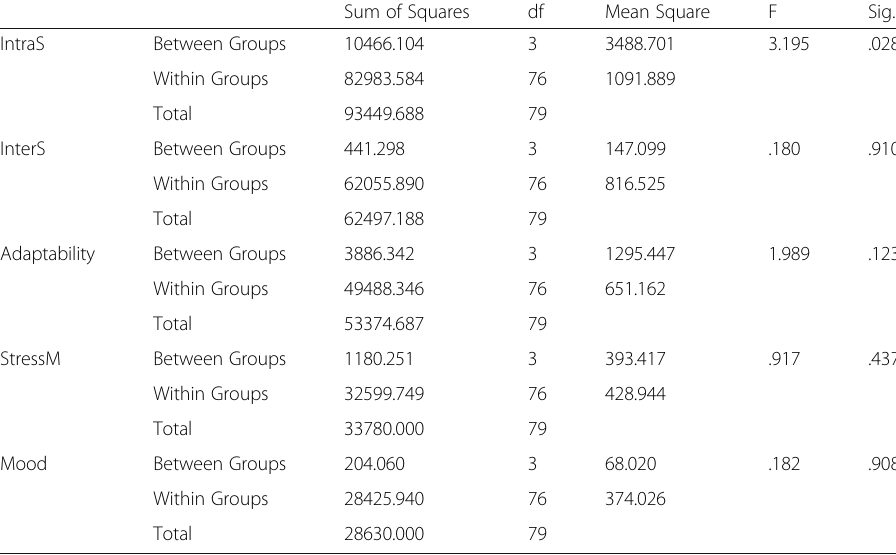
Table 5 Summary of ANOVA Results for EI Subscales Sum of Squares df Mean Square F Sig.